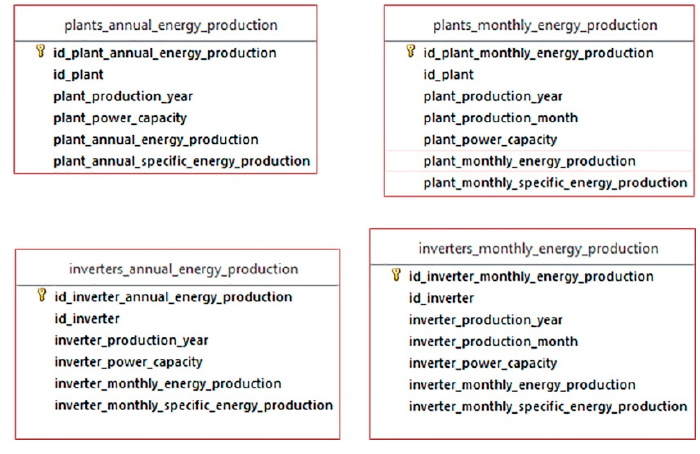
Figure 13. The performance ratio checks group of the relational database.